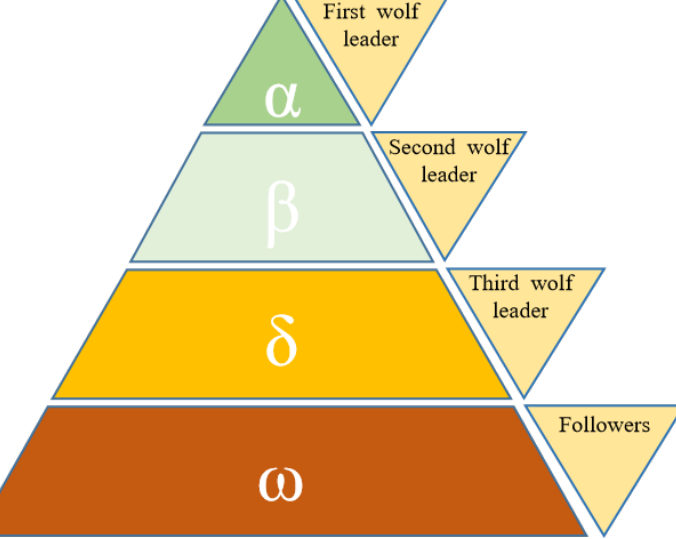
Figure 2. Hierarchy of the Gray Wolf Pack (dominance decreases from top down). 3.1.1. Approaching and Encircling Behavior of Wolves towards Their Prey Gray wolves will surround the prey in the hunting process, and when the current → X ( t ) and the position information of the position of the gray wolf pack is expressed as → X p ( t ) , the hunting behavior of the gray wolf pack is abstracted into a prey is expressed as mathematical model, as shown in Equations (1) and